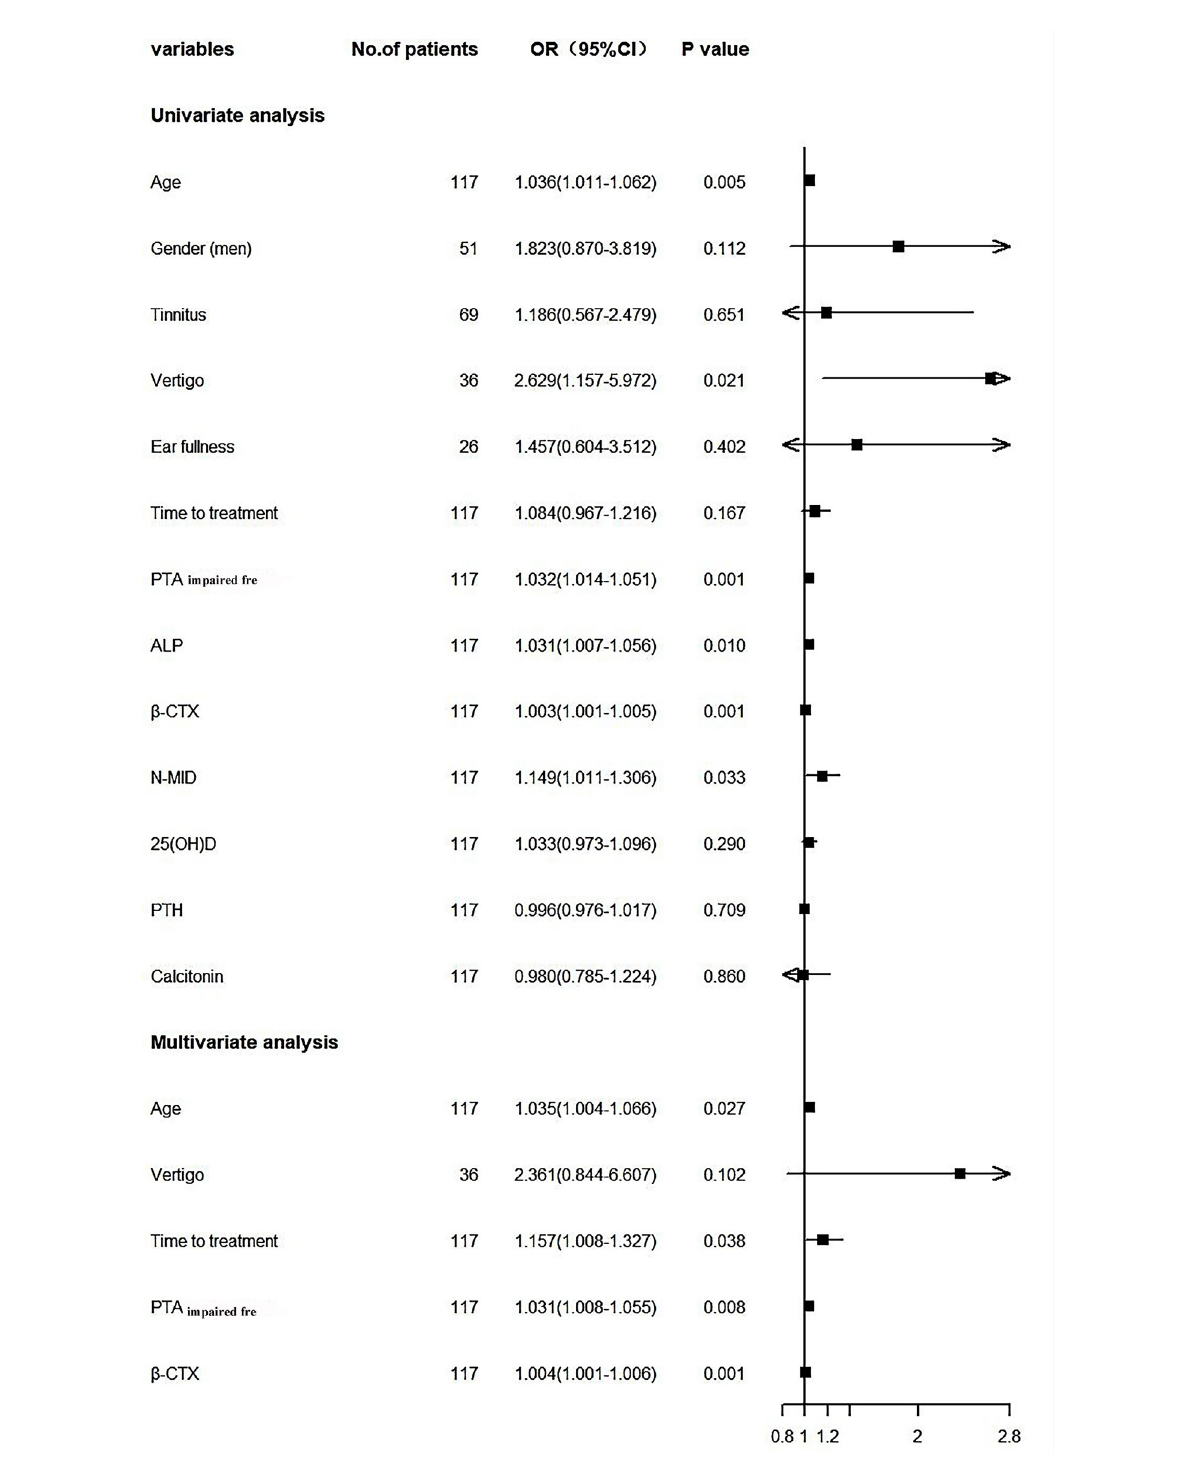
FIGURE2 Forest plot. PTA impairedfre , Pure tone average of the impaired frequencies (0.125–8kHZ); ALP, Alkaline phosphatase; β -CTX, β -carboxy terminal crosslinked telopeptide of type 1 collagen; N-MID, N-terminal-midfragment of osteocalcin; 25(OH)D, 25 hydroxyvitamin D; PTH, parathyroid